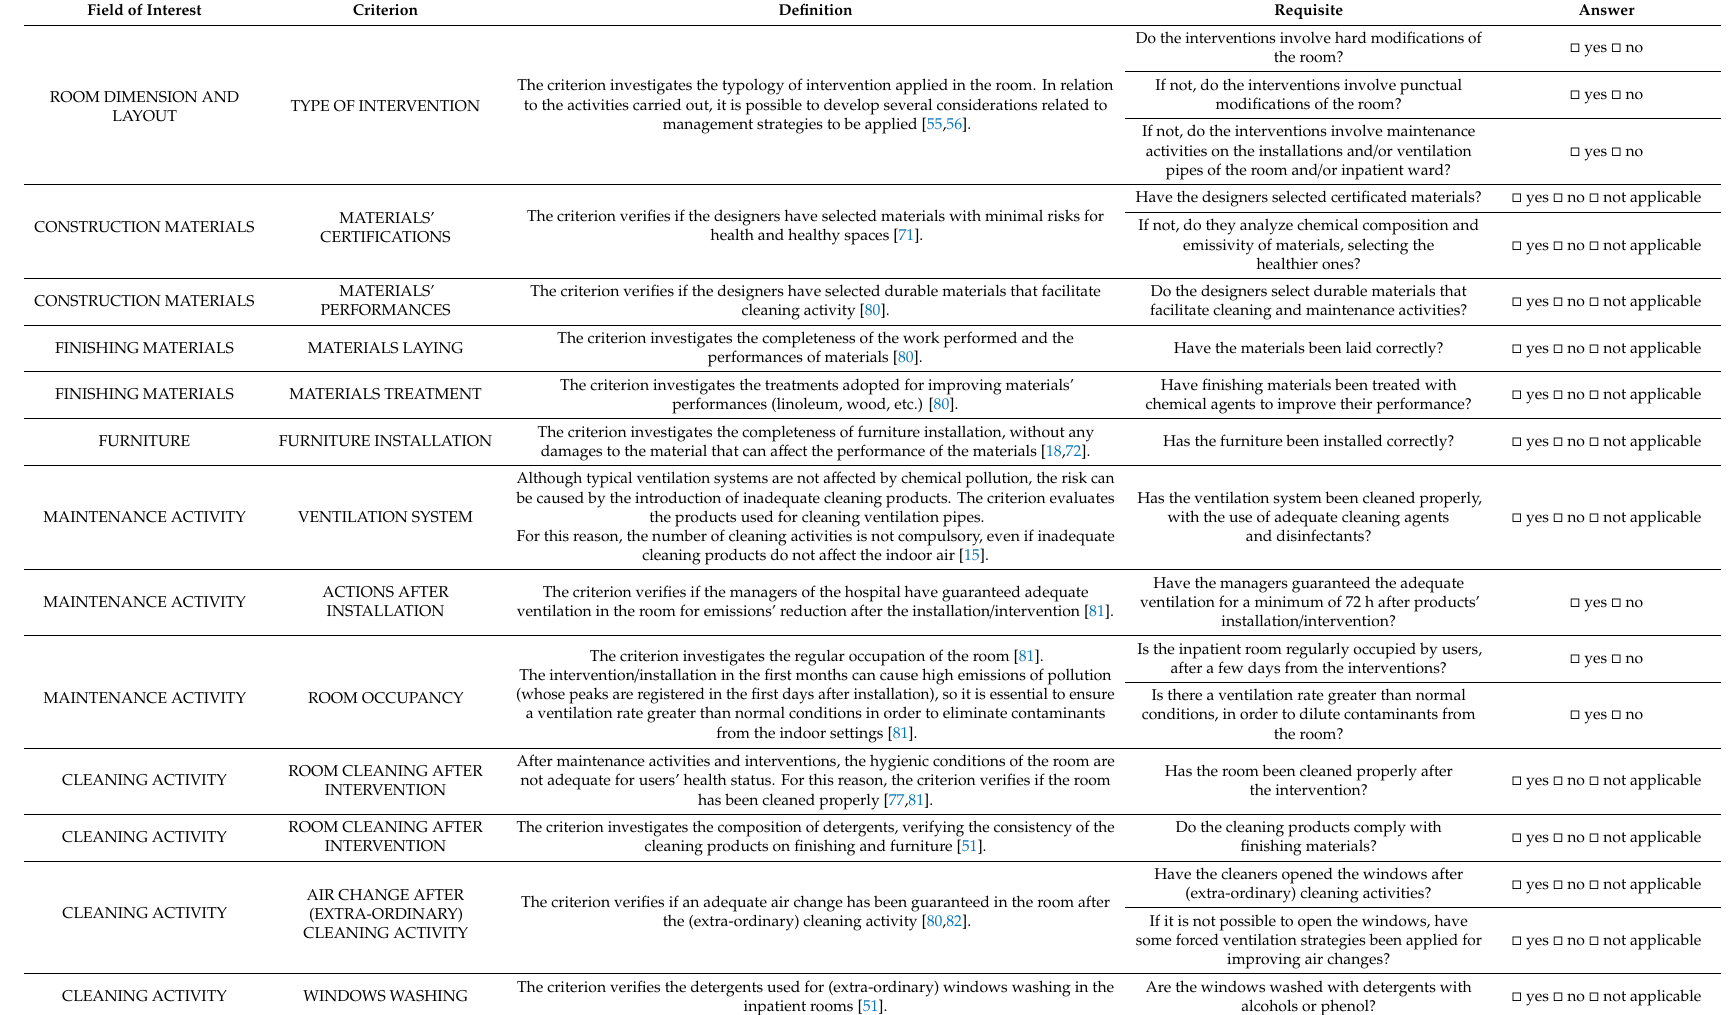
Table 5. Check-list for maintenance activities and